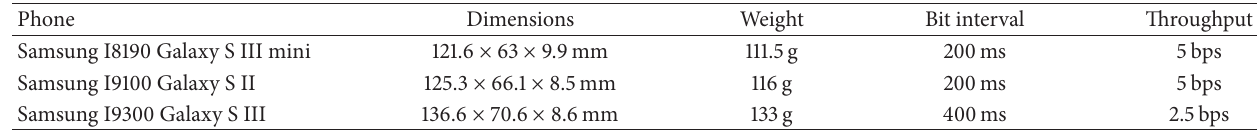
Figure 12: (a) The result of applying the extraction method on modulated acceleration signals from Samsung S3. (b) The decoded bits and equivalent 7-bit ASCII codes. Table 3: List of tested phones with specifications and corresponding